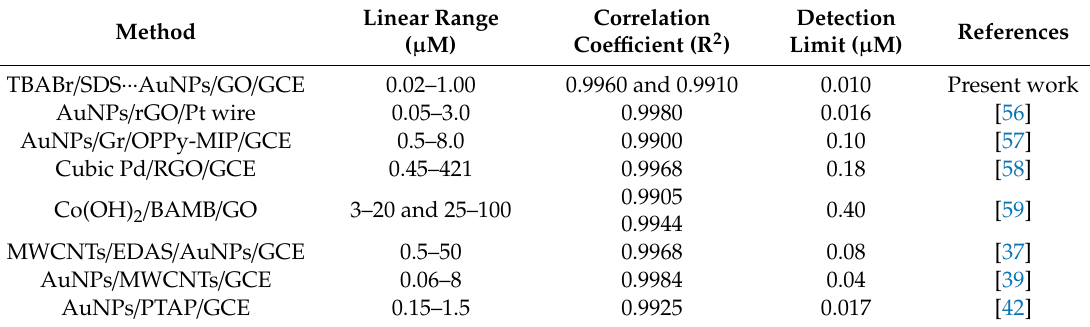
Figure 7. The di ff erential pulse voltammetry (DPV) calibration of DA at the supramolecular electrochemical sensor (TBABr / SDS · AuNPs / GO / GCE) in 0.1 M bu ff er (pH 7.0) at a scan rate of 50 mV / s. Inset: the I p versus concentration. Table 1. Comparison of the proposed method with the literature methods for dopamine (DA) determination. TBABr / SDS,tetra-butylammoniumbromide / sodiumdodecylsulphate; AuNPs / GO / GCE, gold nanoparticles on graphene oxide modified on glassy carbon electrode; RGO, reduced graphene